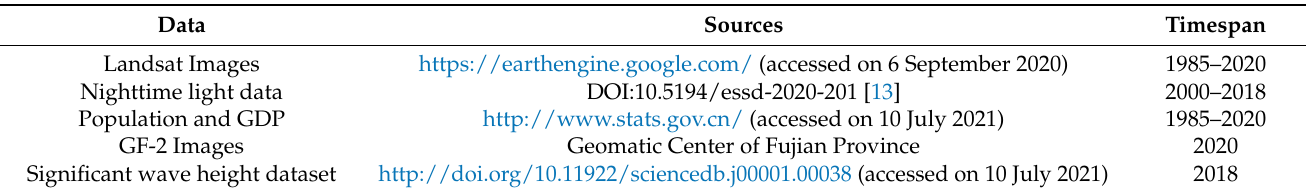
Table 1. Employed datasets in this study.